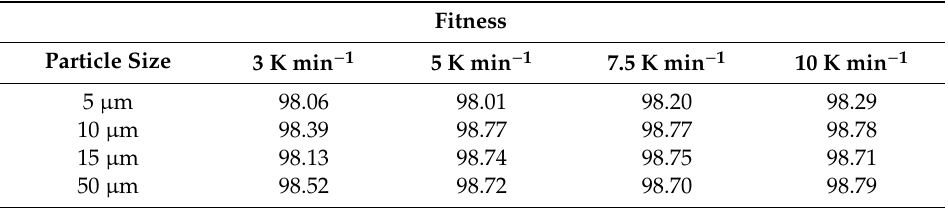
Table 6. DAEM fitness for di ff erent particle size with di ff erent heating